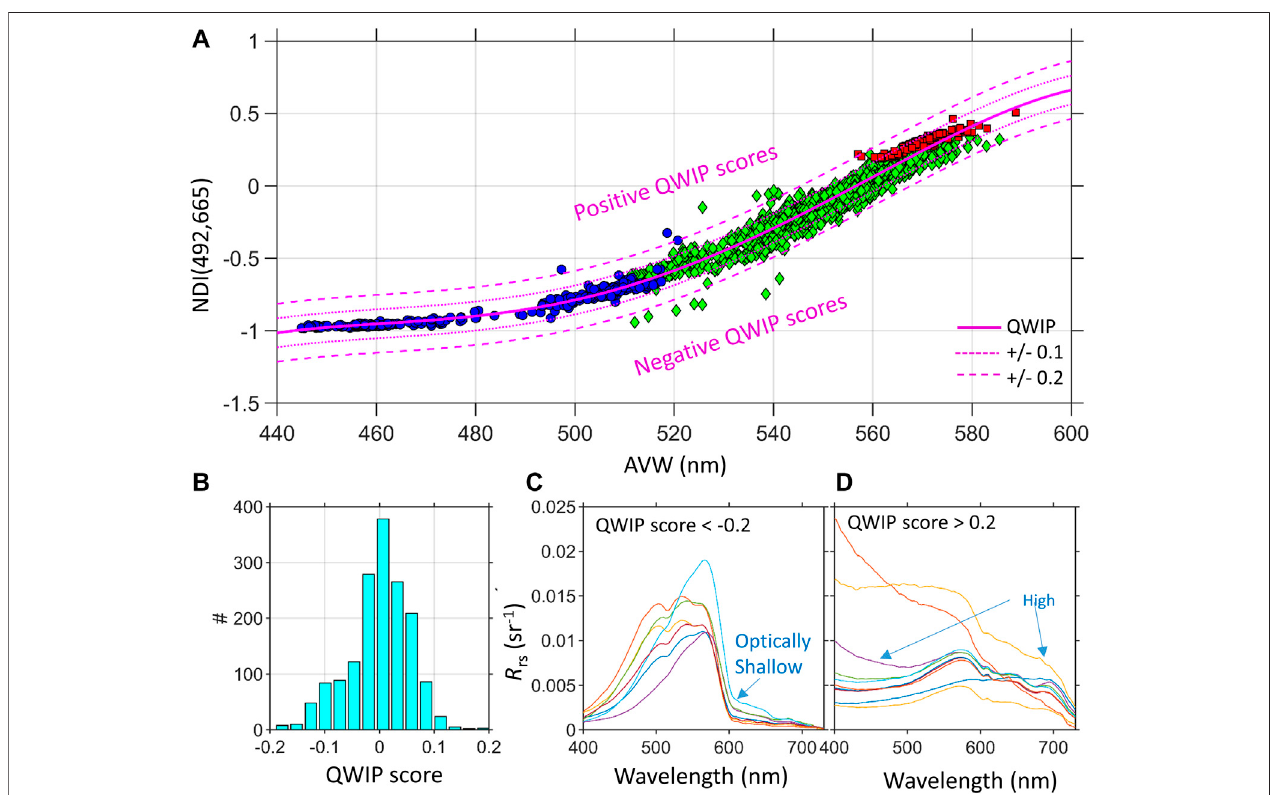
FIGURE 4 | (A) The QWIP relationship between Apparent Visible Wavelength (AVW) and the Normalized Difference Index (NDI) with the CASCK-P training dataset showingthe fi naltunedQWIPpolynomial(thickmagentaline)withdifferentlevelsofQWIPscores(±0.1dottedmagentaand±0.2dashedmagenta).Watertypesinclude: Blue-green (blue circles), Green (green diamonds) and Brown (red squares). (B) Histogram of the QWIP scores from (A) are predominantly within ±0.1 for the training data. (C) The remote sensing re fl ectance ( R rs ) of outliers with negative QWIP scores < − 0.2 were associated with optically shallow water features. (D) Outliers with QWIP scores > 0.2 exhibited higher blue associated with surface re fl ected skylight and higher overall magnitude spectra.